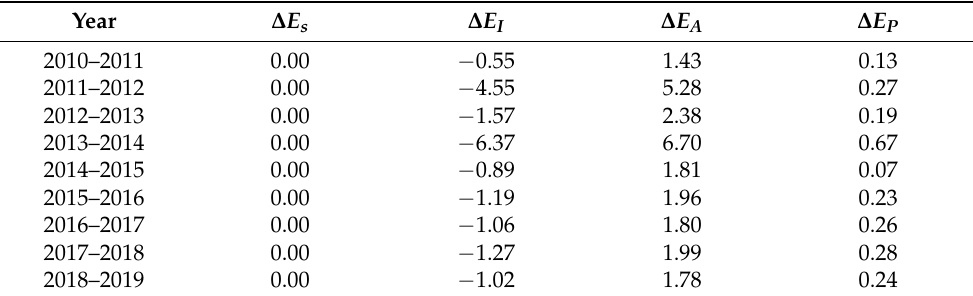
Table 4. Decomposition proportions of energy consumption factors in Zhejiang Province from 2010